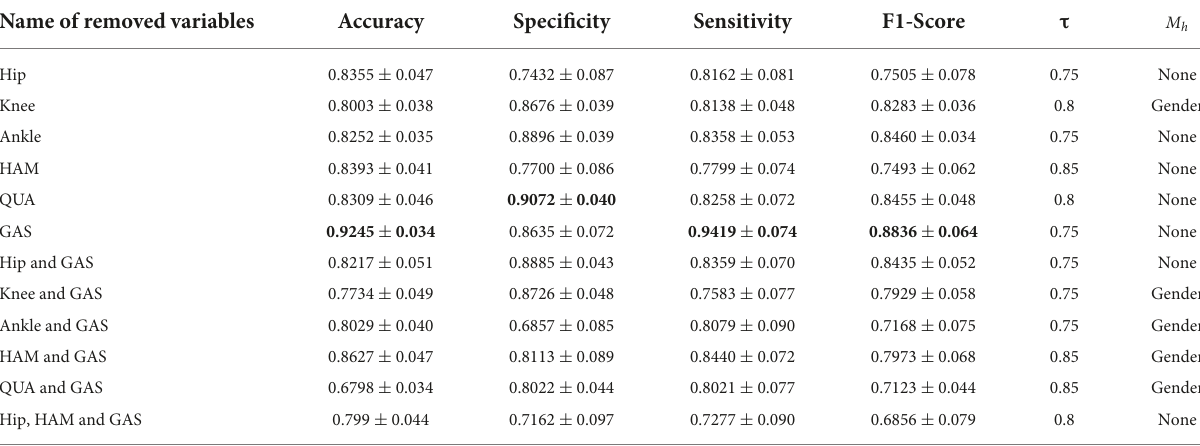
TABLE 4 Classification performance of FBI-GCN with removed composition variables.